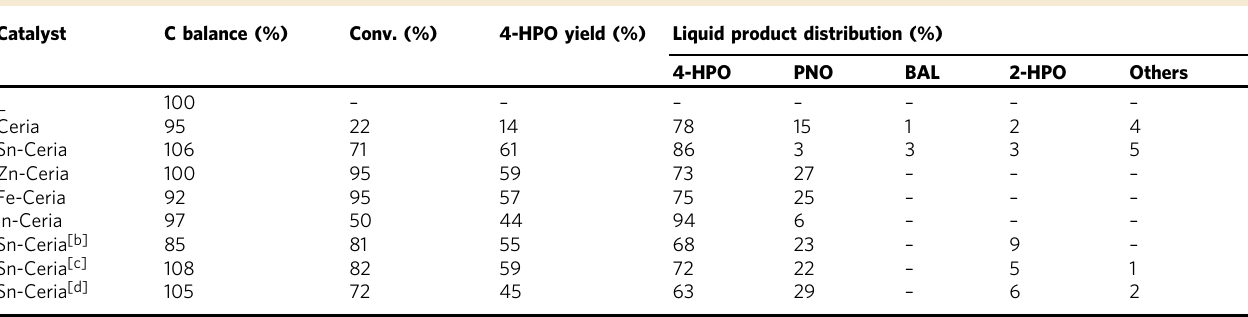
Table 1 Conversion of aqueous ABE solution over various catalysts [a]